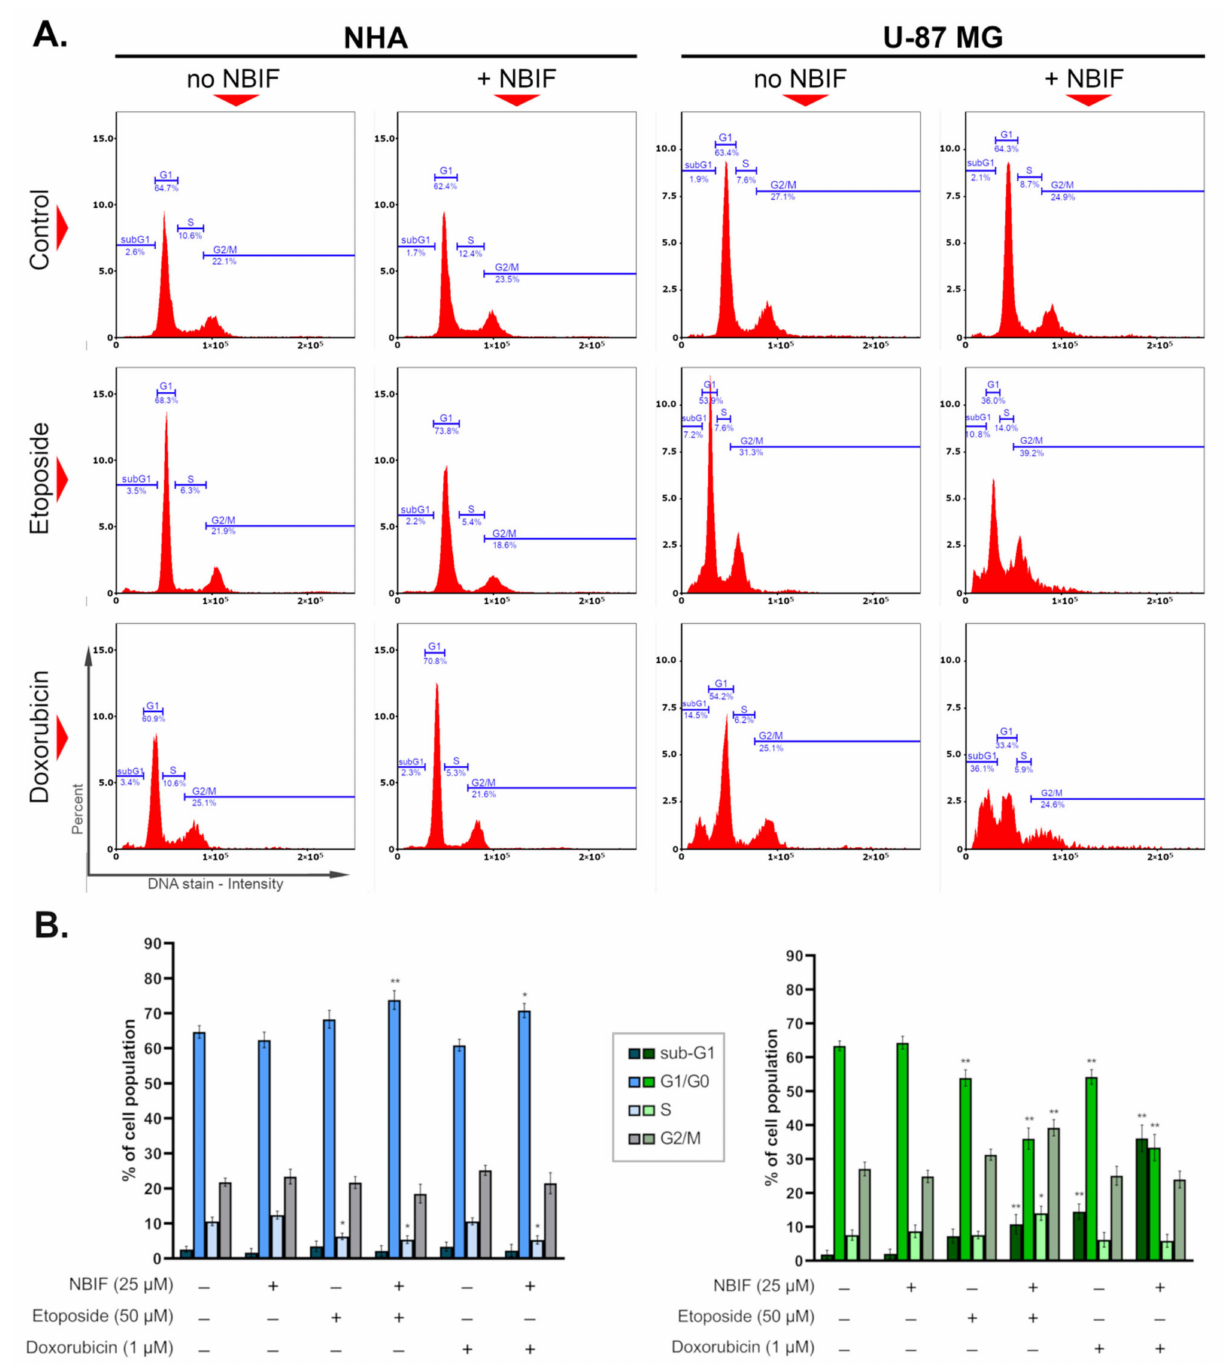
Figure 4. The influence of etoposide (50 µ M), doxorubicin (1 µ M) and their mixes with NBIF (25 µ M) on the cell cycle profile in NHA and U-87 MG cells (48 h of treatment). ( A ) Representative histograms showing the distribution of cells with different DNA content in the cell cycle phases. ( B ) Mean values and SD of percentage of cell subpopulations in different cell cycle phases (bar graphs: left–NHA cells, right–U-87 MG cells) from three independent experiments in at least triplicate The results are presented as percent of corresponding control. * p < 0.05, ** p < 0.001 vs.